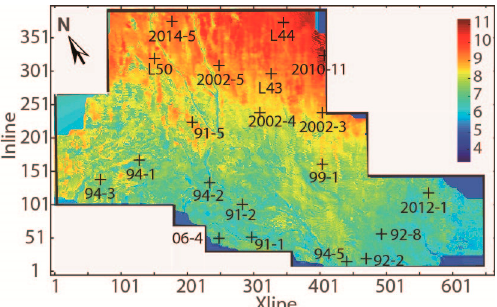
Figure 10. The predicted TDC thickness in meters of coalbed No. 8 in the study area. The “+” markers indicate the well locations, and the labels beside the markers are well names.